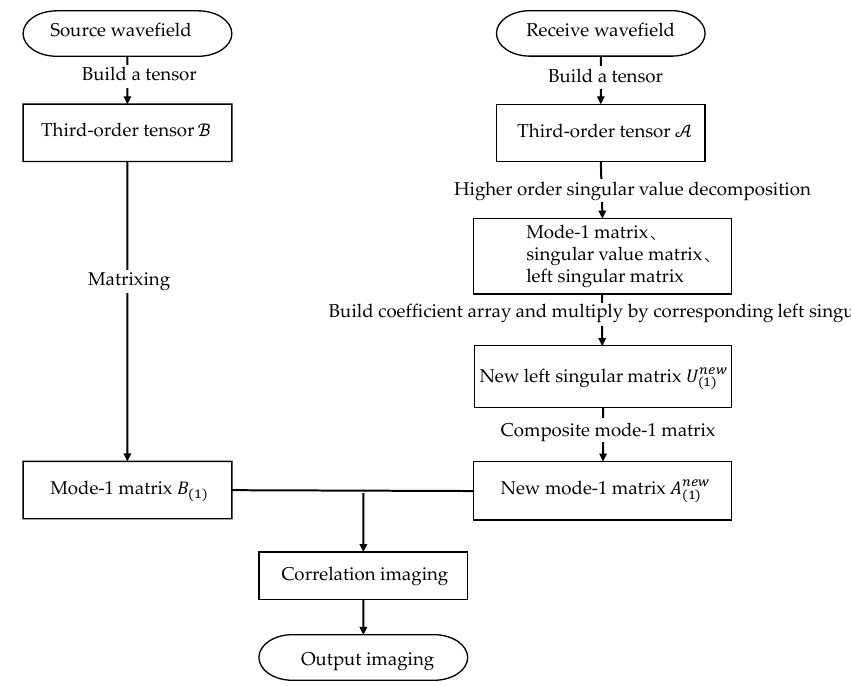
Figure 2. Unfolding of the third-order tensor.